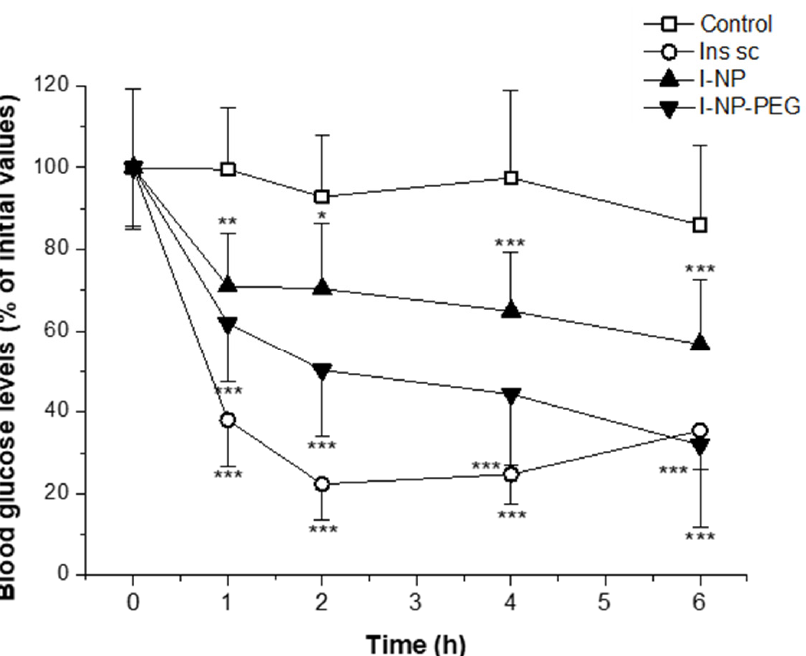
Figure 8. Blood glucose levels (% of initial values) of streptozotocin-induced diabetic rats after administration of subcutaneous solution of insulin (Ins sc; 5 IU/Kg) or oral administration of water (control), insulin-loaded bare nanoparticles (I-NP; 50 IU/Kg), or insulin-loaded PEG-coated nanoparticles (I-NP-PEG; 50 IU/Kg). Data expressed as mean ± S.D. ( n ≥ 6). * p < 0.05; ** p < 0.01; *** p < 0.001, compared to control.